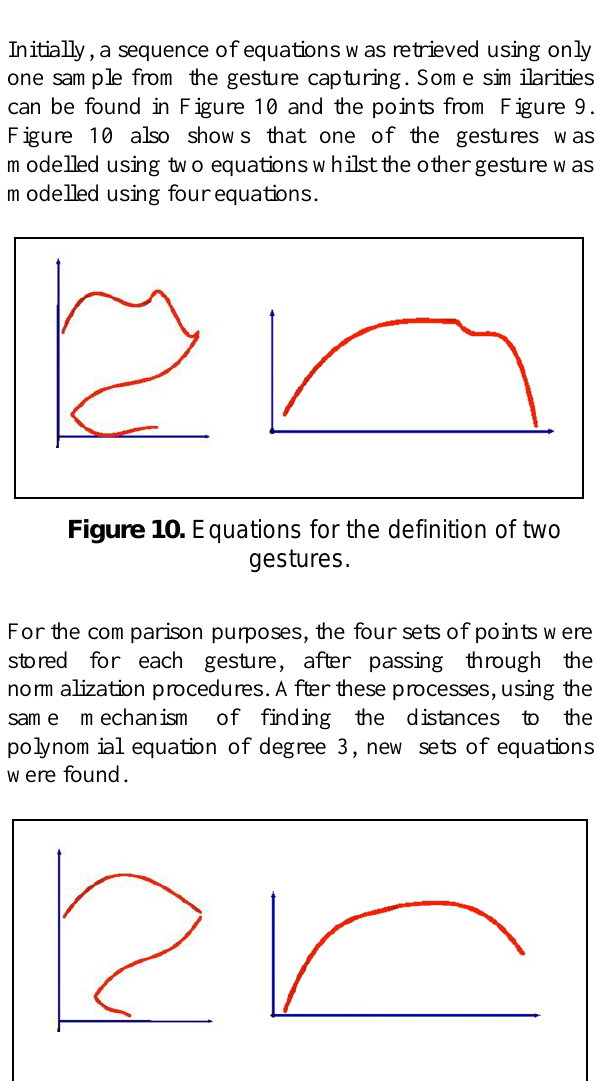
Figure 9. Set of points stored for each gesture (one colour for each sample).